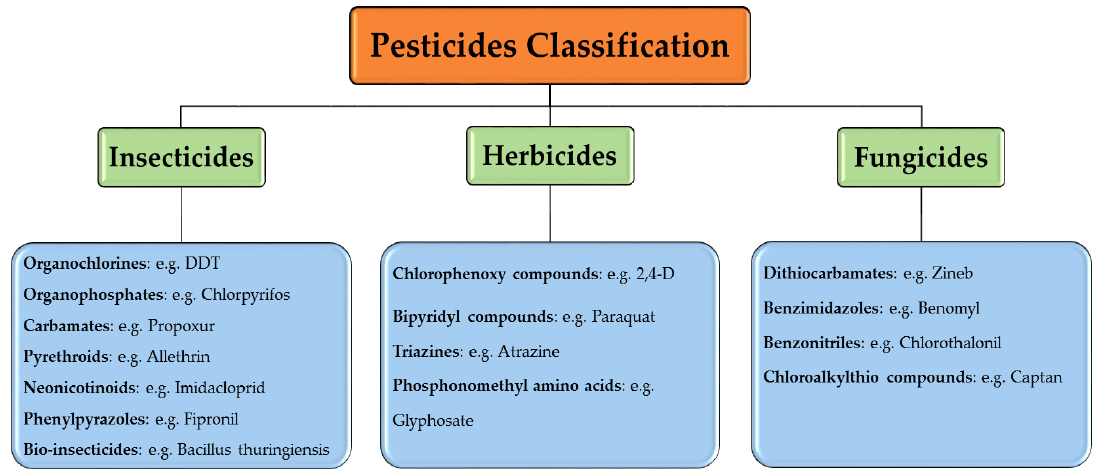
Figure 4. Pesticide classification by pest they kill and the chemical composition (Modified after Yadav and Devi [57]; Fishel and Ferrell [58]).